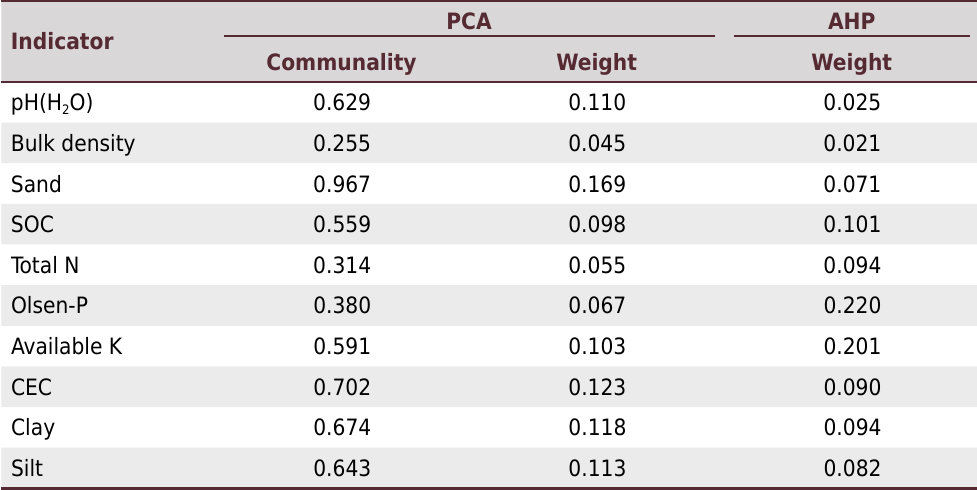
Table 4. Estimated communality and the weight value of each soil quality indicator Indicator